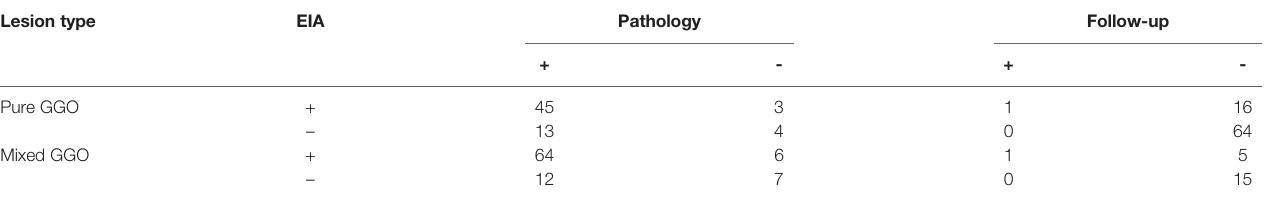
TABLE 5 | Diagnostic result of Electrical impedance analysis (EIA) compared with pathology and follow-up in subsolid lesions. Lesion type EIA Pathology